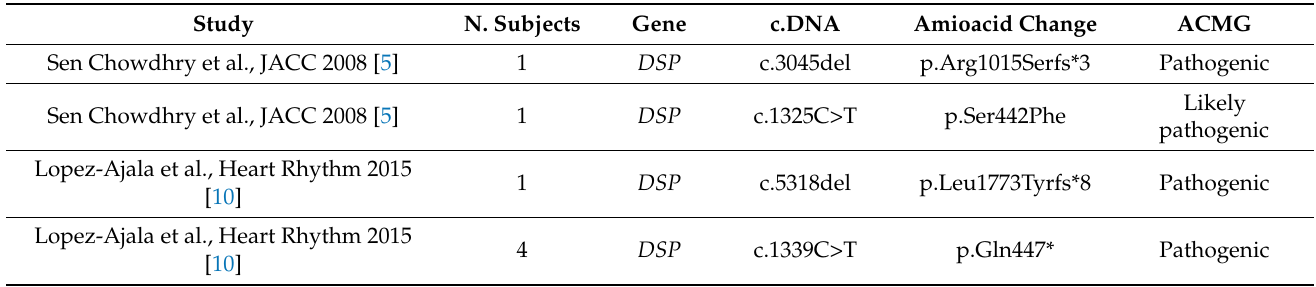
Table 3. Genetic variants reported in ACM patients who showed hot-phase